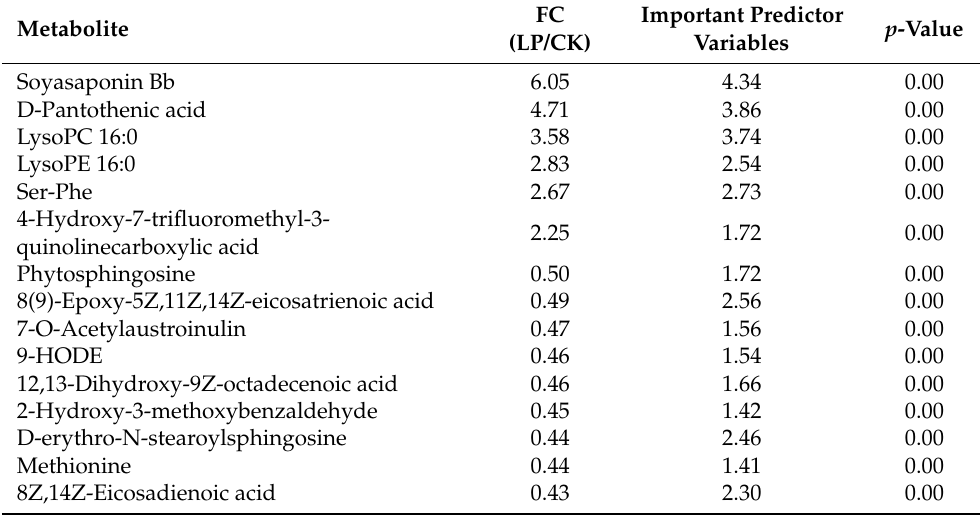
Table 6. Metabolite differences of whole crop corn silage between LP and CK